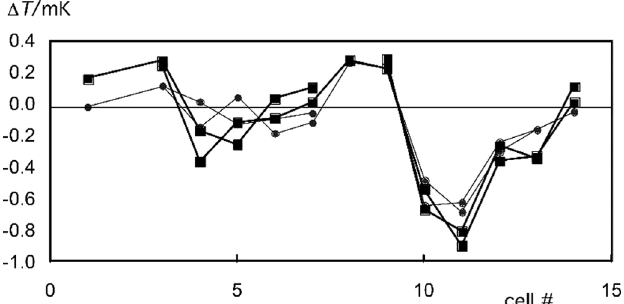
Fig. 2. Graphical representation of the corrected data D T = ( T meas,ac – T KCRVac ) from Table 3 and the uncorrected data D T = D T original from Table 2, for cells #1 to #15 and for thermometer sets #1 and #2. Gray dots and lines: uncorrected differences. Black squares and lines: isotopic-corrected differ-